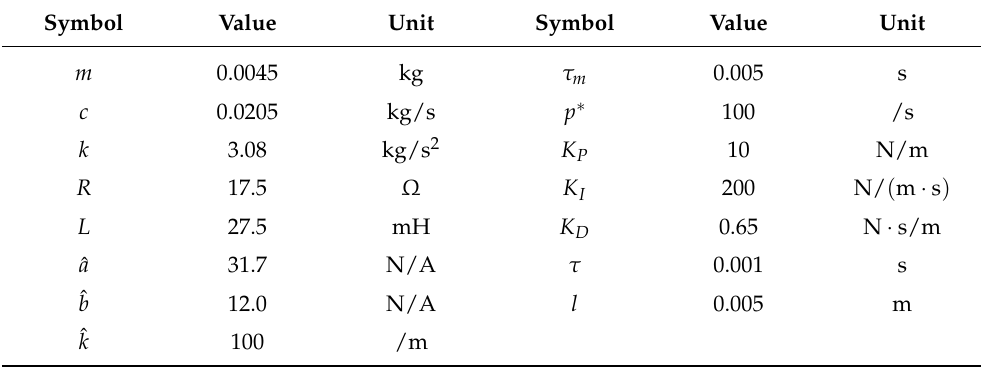
Table 3. Parameters of the